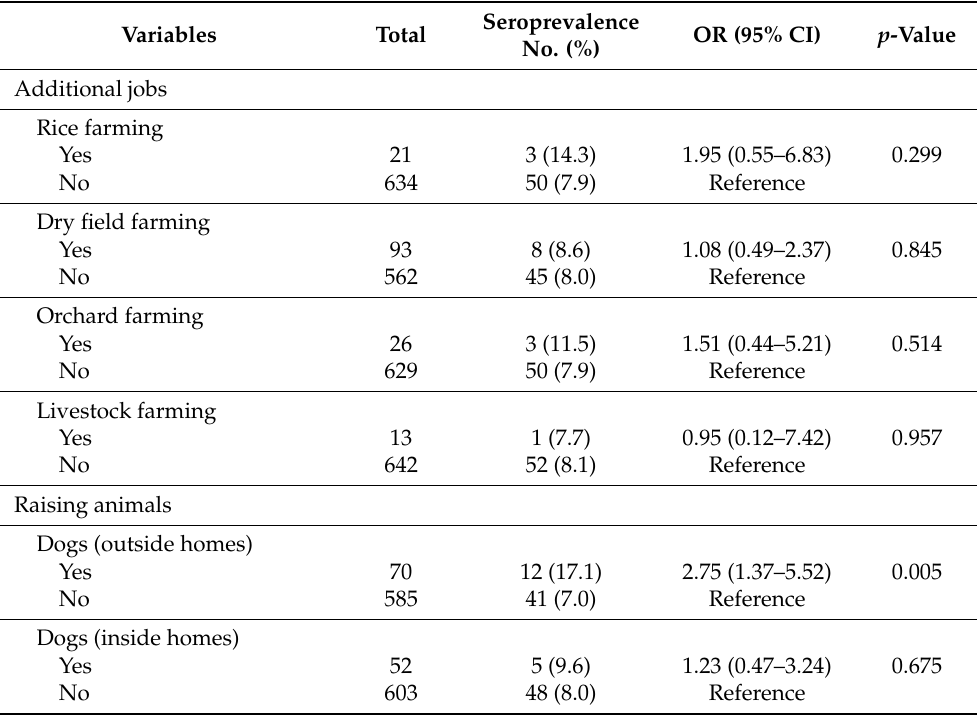
Table 5. Univariate logistic regression analysis between other work-related factors and Lyme disease seroprevalence among National Park Office forestry workers in South